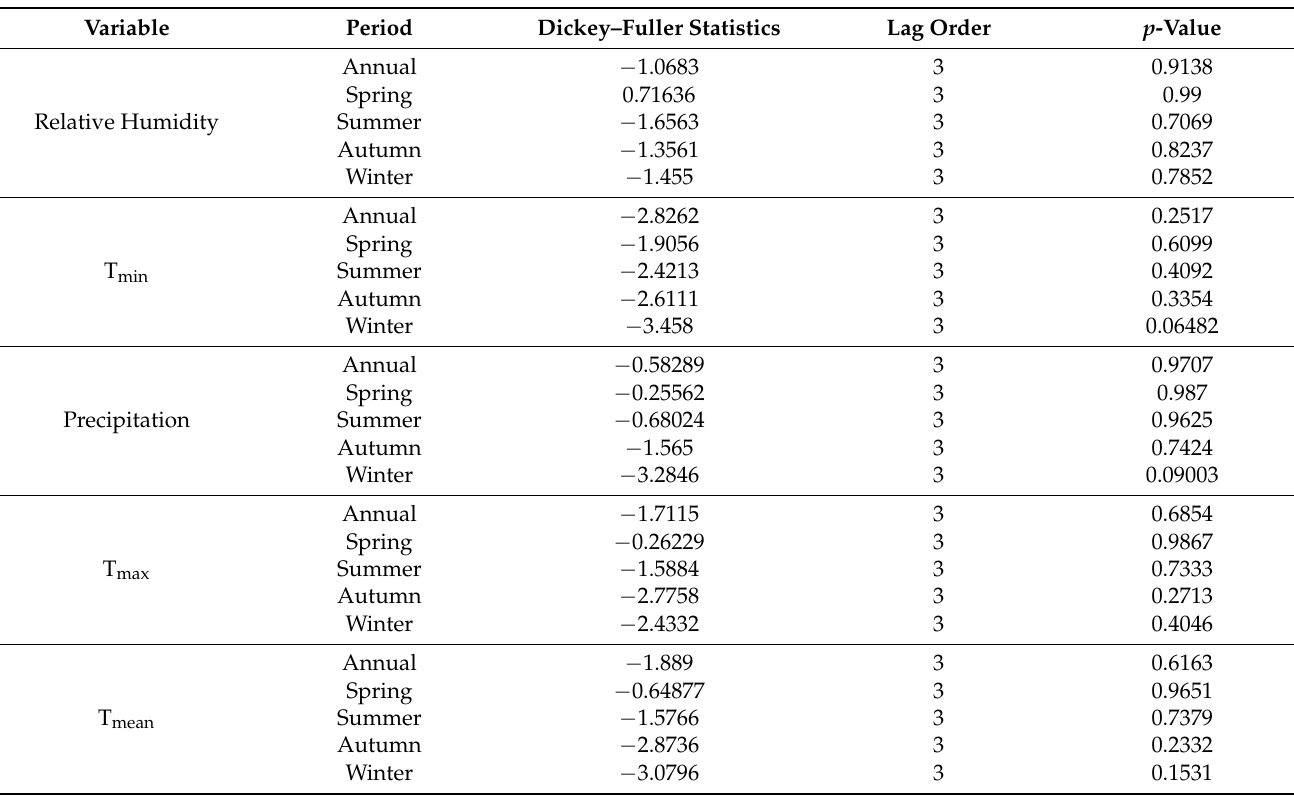
Table 4. Stationarity test results for the datasets from Punjab, Pakistan, over the period 1979–2014.